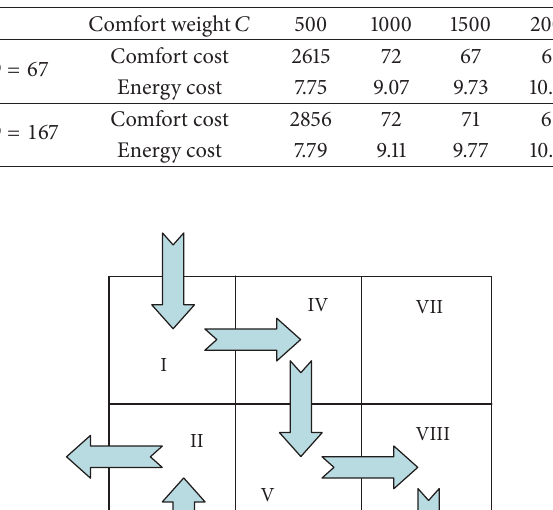
Table 4: Energy and comfort costs for constant occupancy times.